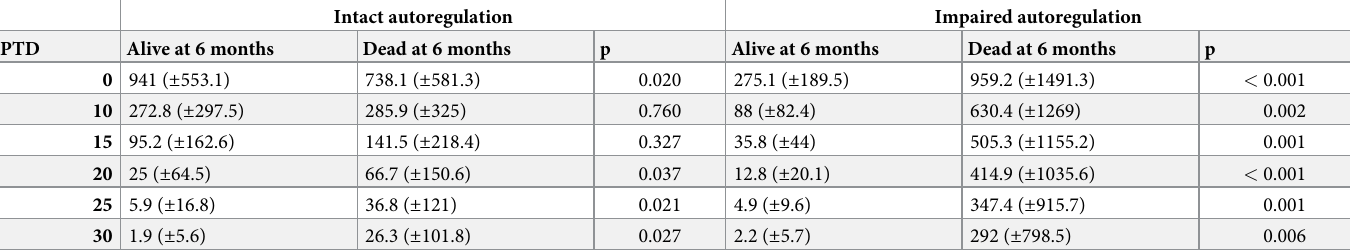
Table 4. Group mean PTD (mmHg � h) of intact or impaired autoregulation above thresholds of ICP, Dead or alive at 6 months, intact and impaired autoregulation. Intact autoregulation Impaired autoregulation PTD Alive at 6